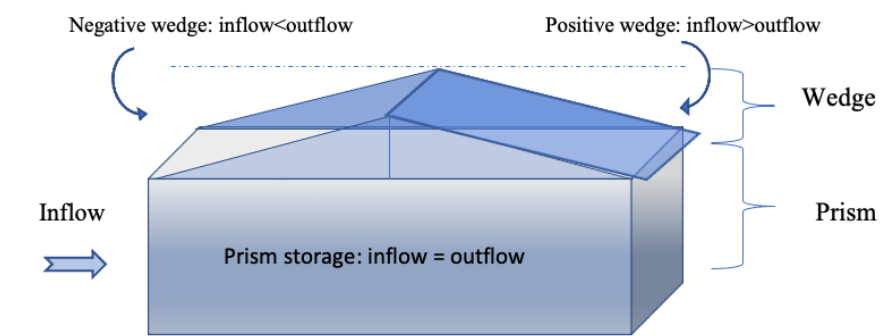
Figure 2. Prism and wedge storage concepts, graphically.